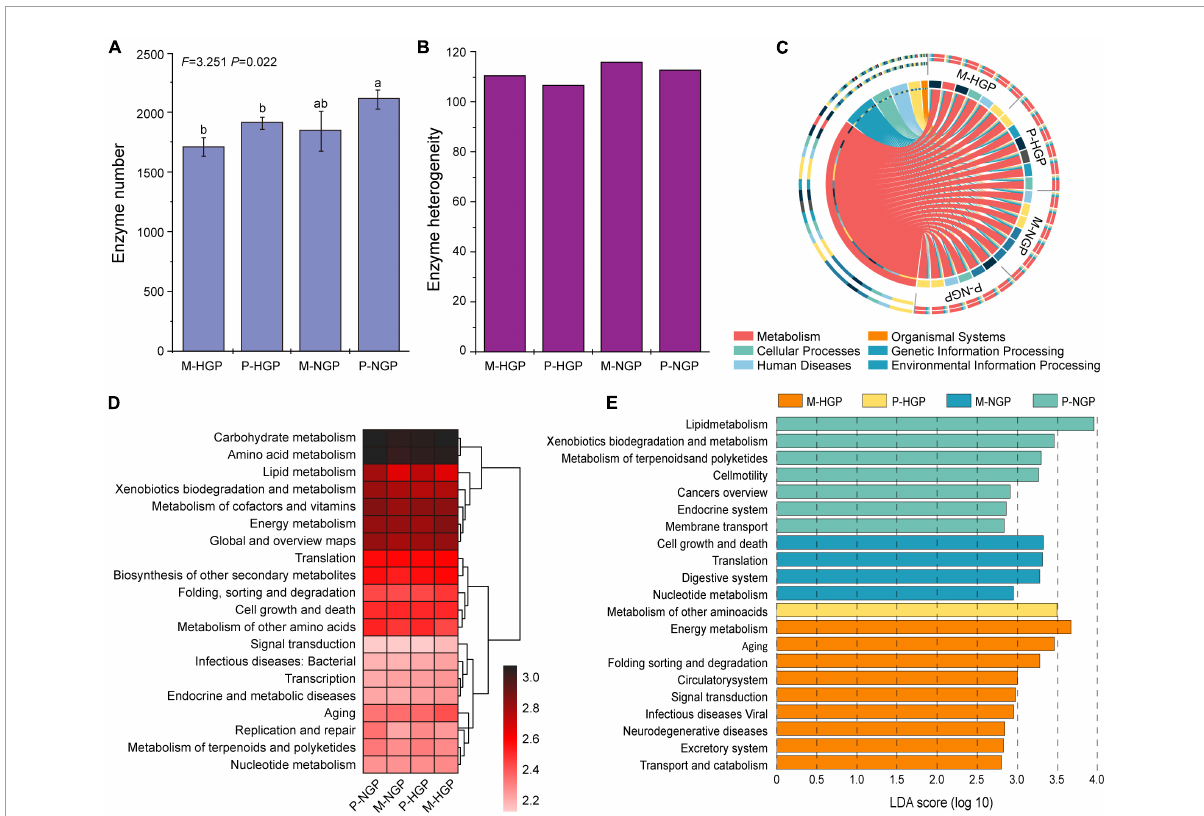
FIGURE5 Response of soil microbial function to grazing exclusion. (A) The number of enzymes in the four sampling sites (M-HGP, P-HGP, M-NGP, and P-NGP). Different lowercase letters indicate significant differences ( p < 0.05). (B) Heterogeneity of enzymes. (C) Proportions of functional microbes (KEGG level 1) in each sample ( n = 24). (D) The relative abundance of the top 20 functions (KEGG level 2), where color depth indicates the relative abundance of genes. (E) Functional biomarkers (KEGG level 3) with an LDA score (log 10) of > 2.5. Different colors indicate different sampling